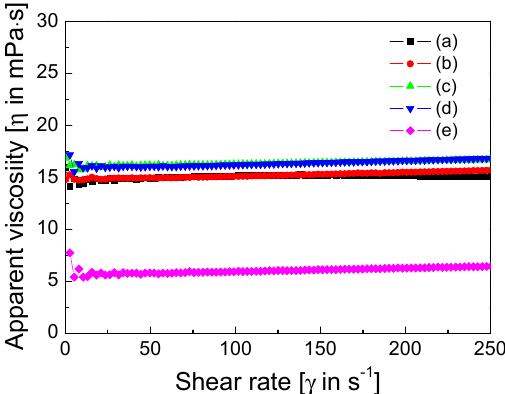
Figure 3. Variation in the viscosity of the MSA solution as a function of the concentration of added water: (a) 0 M, (b) 1.1 M, (c) 5.0 M, (d) 9.3 M, and (e) 20.8 M.